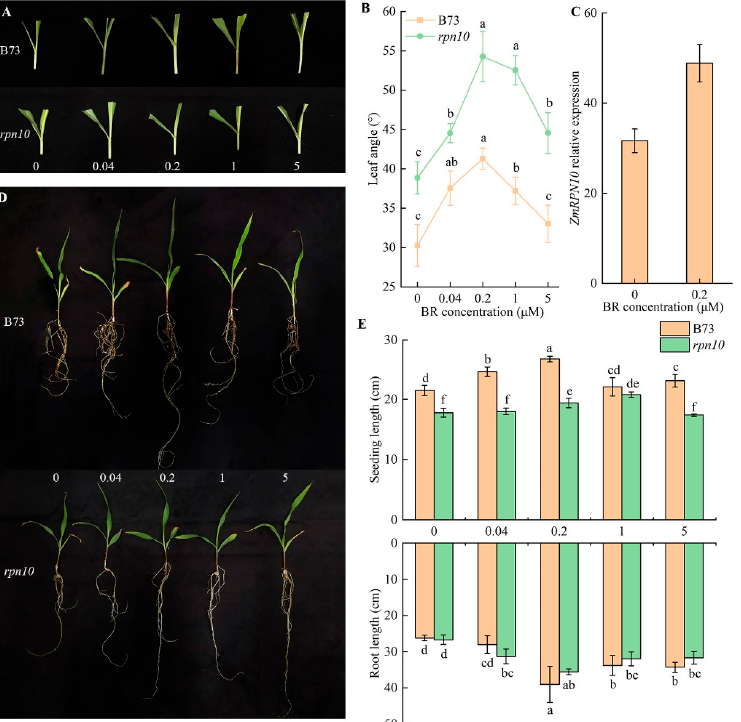
Figure 3. The effects of exogenous BR treatment on B73 and rpn10 seedlings ( A ) Effects of exogenous BR treatment on leaf angle between B73 and rpn10 seedlings; ( B ) The size of leaf angle between B73 and rpn10 seedlings under exogenous BR treatment. Different lowercase letters on the same line indicate significant differences between treatments, p < 0.05; ( C ) Relative expression levels of ZmRPN10 under 0.2 µ mol/L exogenous BR treatment; ( D ) Seedling morphology of B73 and rpn10 under different exogenous BR treatments; ( E ) Morphological changes of B73 and rpn10 at seedling stage under different exogenous BR treatments (0 = 0 µ mol/L BR, 0.04 = 0.04 µ mol/L BR, 0.2 = 0.2 µ mol/L BR, 1 = 1 µ mol/L BR and 5 = 5 µ mol/L BR). Different lowercase letters indicate significant difference between different treatments, p < 0.05.